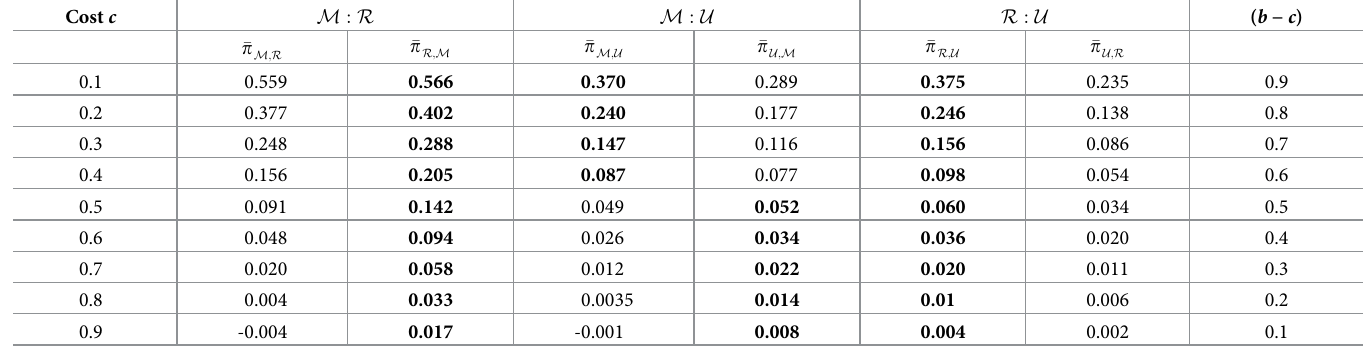
Table 1. Pairwise competitions of players with different memory spaces. We consider the learning dynamics among players with different memory spaces. Players either use memory-1 strategies ( M ), reactive strategies ( R ) or unconditional strategies ( U ). Within their respective memory space, players adapt their strategies to their opponent using introspection dynamics [48, 49] with a selection strength of β = 100. For each combination of memory spaces, we compute the players’ average payoffs according to Eq (6). The winners of these pairwise comparisons are shown in bold. We find that reactive players outperform both memory-1 opponents and unconditional opponents for all considered cost values. Simulations are run for T = 10 9 time